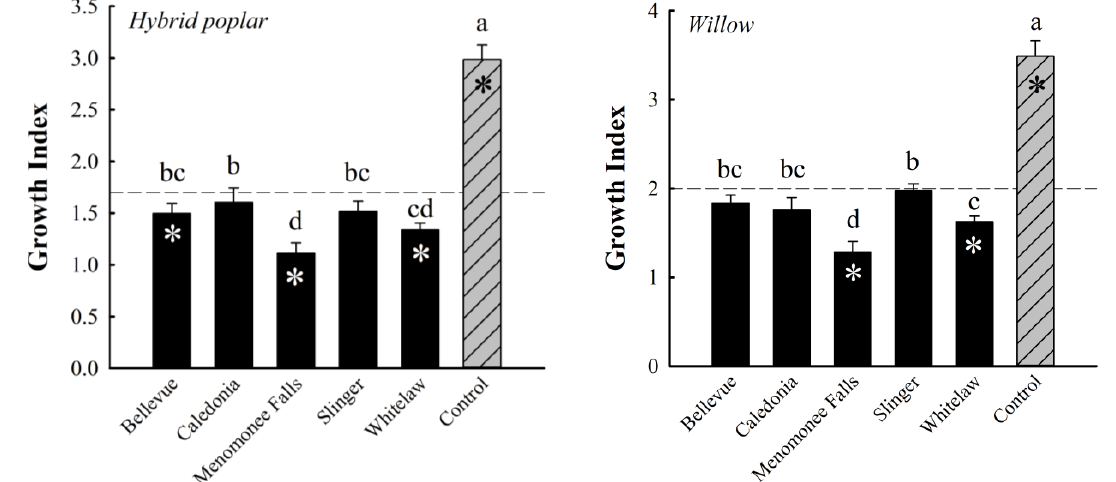
Figure 4. Growth index for the soil treatment main effect in a study assessing the relationships among root–shoot allocations, early growth, and health of hybrid poplar and willow clones when grown for 65 days in soils from five landfills in eastern Wisconsin, USA. The dashed line represents the overall mean, while bars with asterisks indicate means that differ from the overall mean at p < 0.05. Bars with the same letters were not different according to Tukey’s adjustment at p > 0.05. Forests 2018 , 9 , x FOR PEER REVIEW